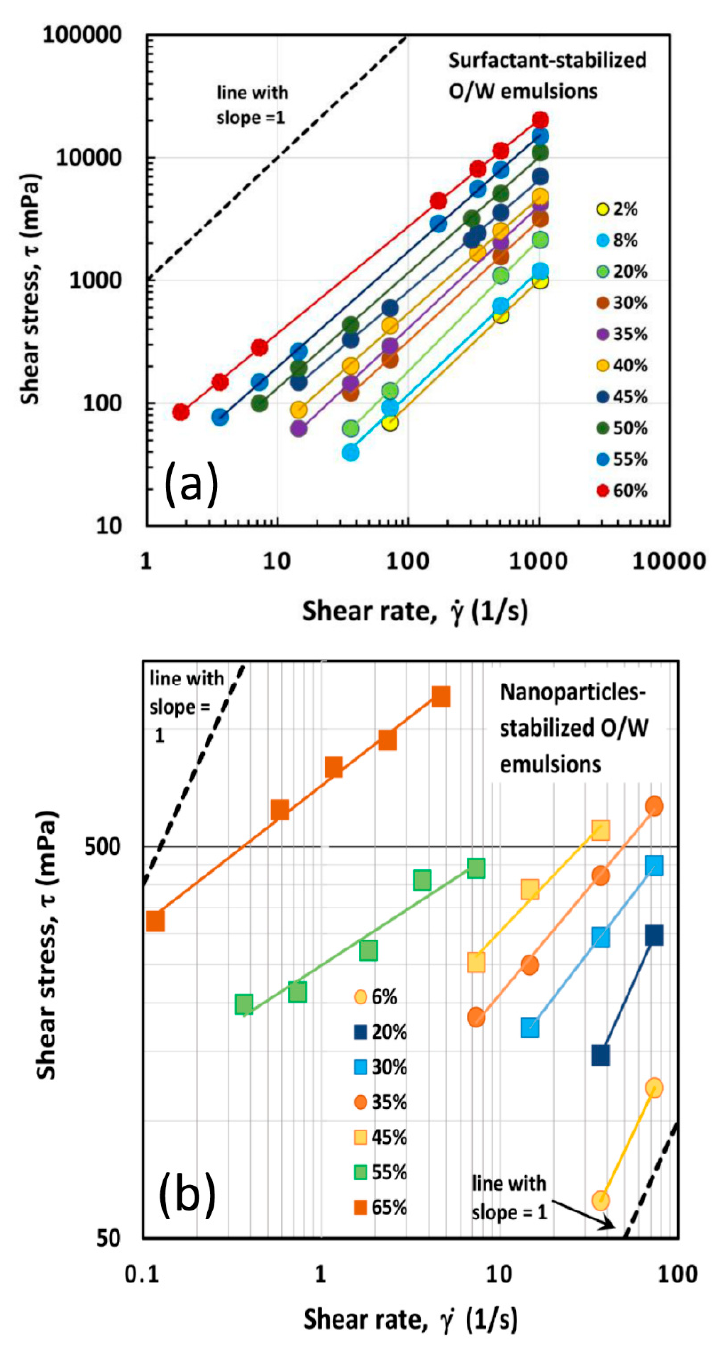
Figure 6. Rheograms of ( a ) surfactant-stabilized and ( b ) nanoparticle-stabilized O/W emulsions at different oil concentrations.